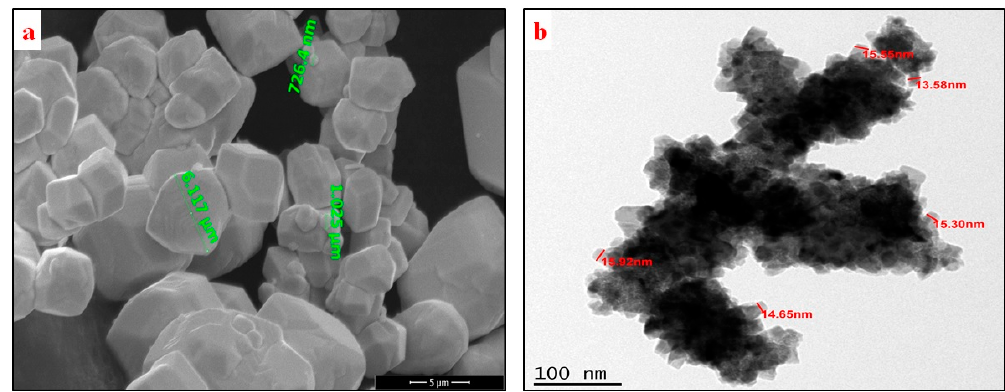
Figure 1. Powder morphology of as-received ( a ) tungsten powder and ( b ) nano-copper powder.